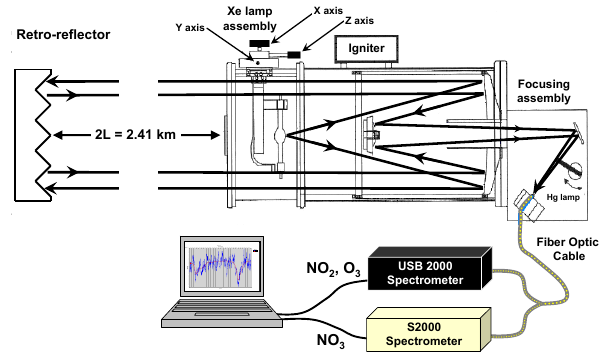
Fig. 2. Instrumental setup of the DOAS